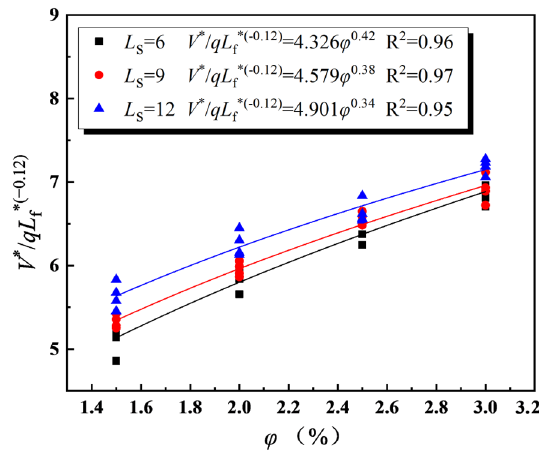
Figure 9. Dimensionless relationship between inlet air velocity and slope ( L f ≤ 330).